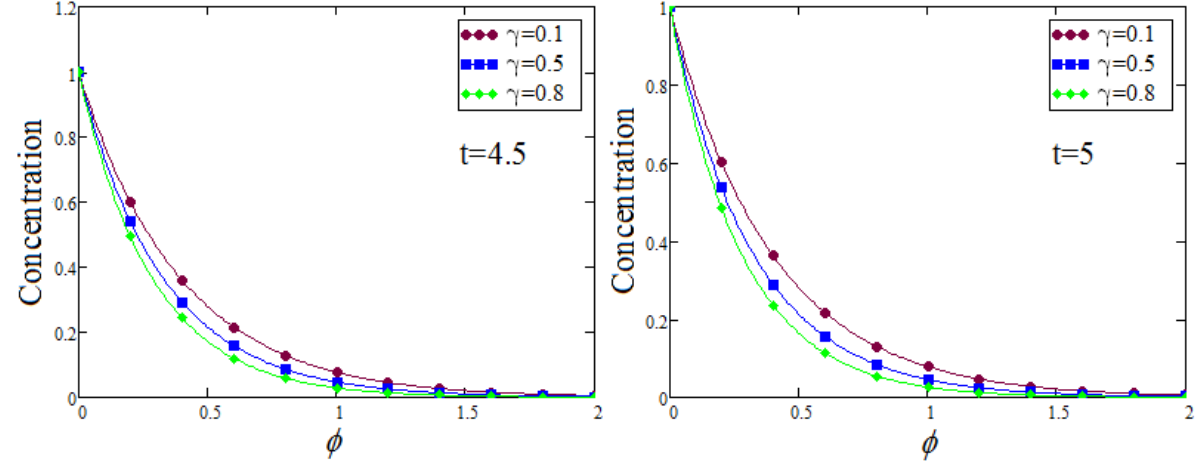
Figure 8. Graphical representations of concentration profile by taking distinct values of γ at two different levels of time, when Sc = 9, ℘ = 0.4, β = 0.3, and α = 0.5.